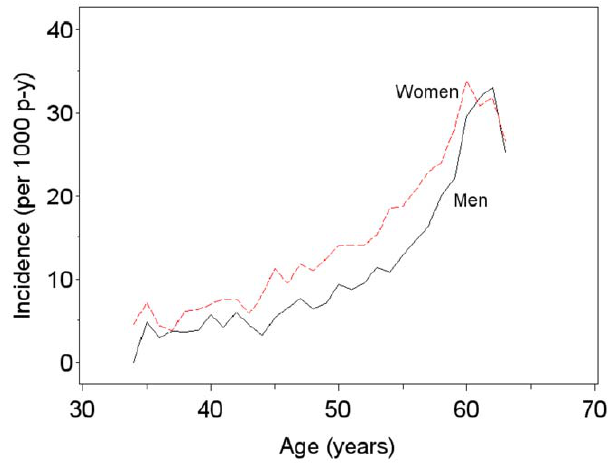
Figure 3. Incidence rates of disability pension per 1000 person- years for women and men.